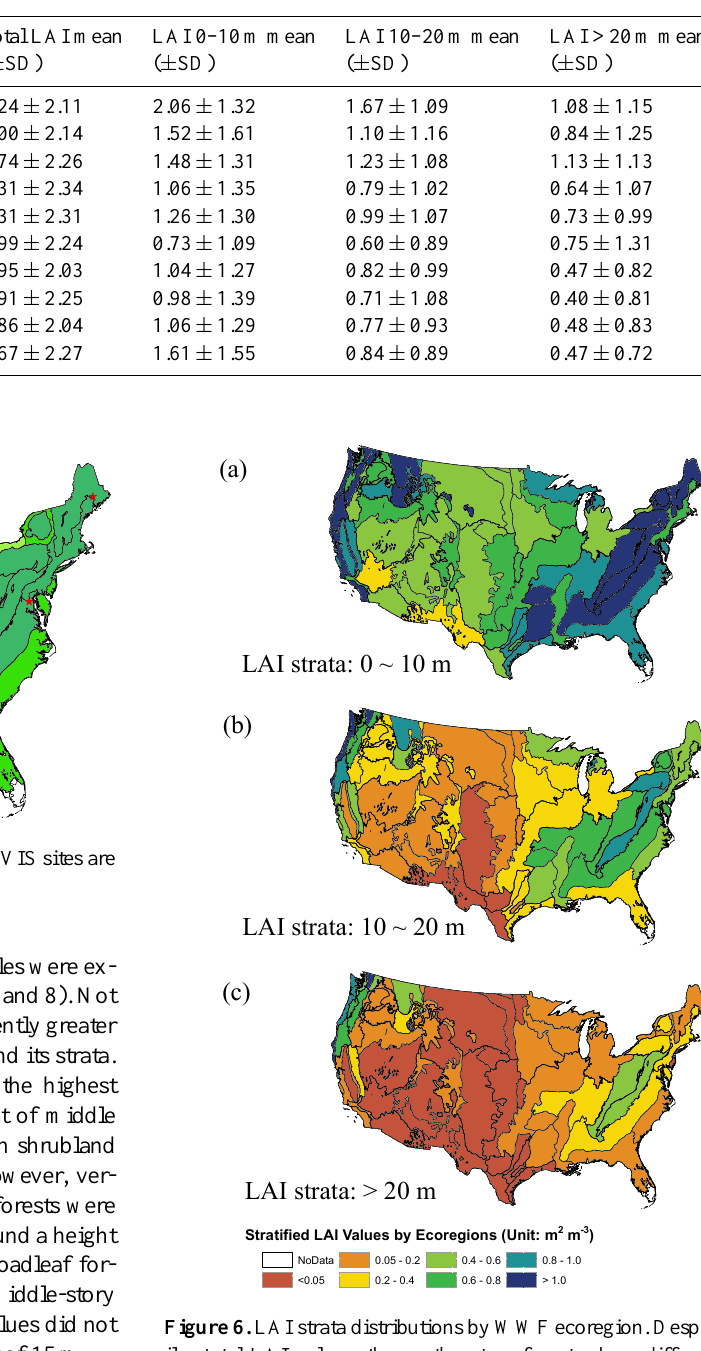
Table 1. Ecoregions with highest total LAI values (unit:m 2 m − 2 ).